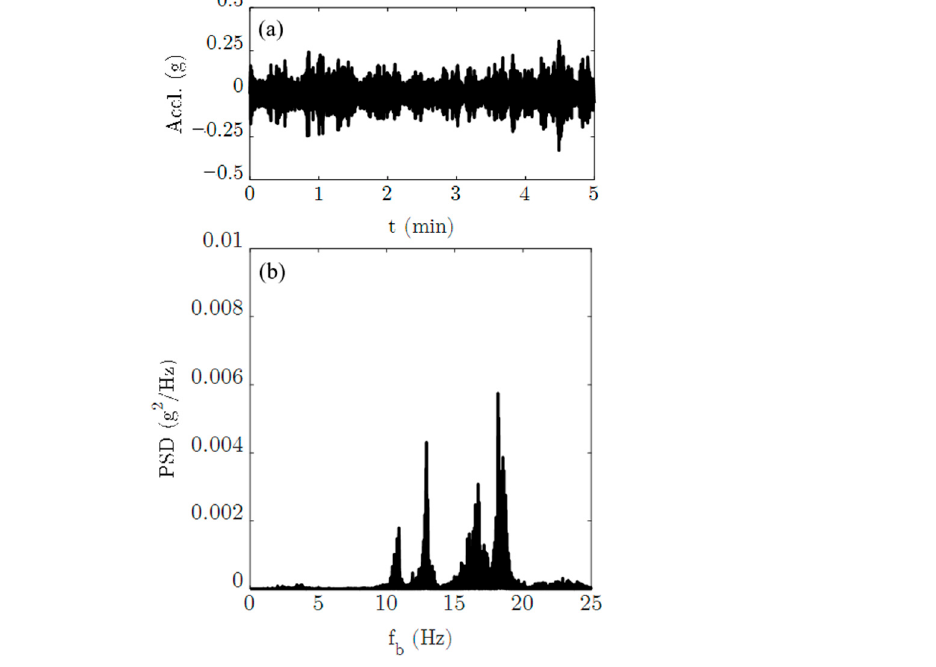
Figure 16. Acceleration of the base excitation recorded by an accelerometer of the model Data Logger X2-5 during the field testing: ( a ) 5 min time-history of the acceleration and ( b ) power spectral density of the acceleration.